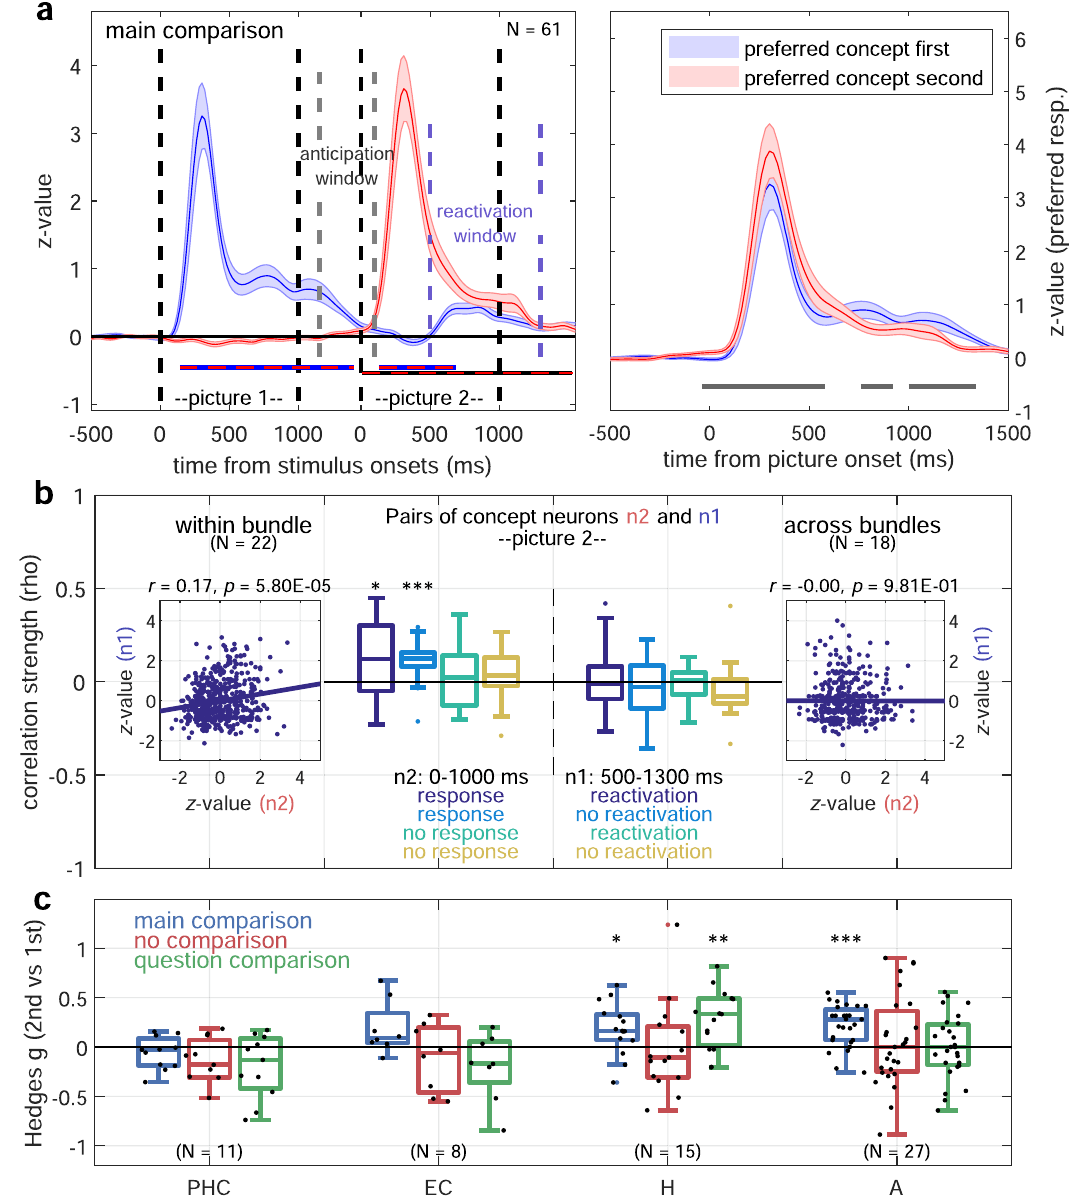
Fig. 5 Relational responses could arise from local interactions of concept neurons. a Left: Averaged normalized fi ring rates of concept neurons (mean ± SEM as shaded areas) when either the fi rst (blue) or second (red) picture was the preferred stimulus. Time periods of signi fi cant differences are indicated by solid lines in respective colors ( p < 0.01; two-sided cluster permutation test, black: zero). When the preferred concept was shown fi rst, neural activity increased before the onset of the second picture (anticipation window, gray dashed lines). Second responses (red) were stronger, and their late phase coincided with reactivations of units responsive to the fi rst picture (reactivation window, blue dashed lines). Right: Direct comparison of positional differences (two-sided cluster permutation test, periods of signi fi cant difference marked in dark gray). b Pairwise activity of concept neurons n2 and n1 with non-identical preferred stimuli during the main experiment in either the response (n2: 0 – 1000 ms) or the reactivation window (n1: 500 – 1300 ms) of picture 2. Pairs from the same hemisphere but different micro-wires were obtained from within ( N = 22, left) or across ( N = 18, right) wire bundles. Boxplots (Q1, median, Q3; whisker: points within ±1.5 IQR) of pairwise Spearman correlation effect sizes (rho) for different trials distinguished by color. Dark blue: both pictures preferred (n1: 1st picture, n2: 2nd picture). Light blue: only second picture preferred by neuron n2 (response). Turquoise: only fi rst picture preferred by neuron n1 (reactivation). Yellow: none of the pictures preferred. Pairwise correlation effect sizes signi fi cantly exceeded zero within bundles whenever the second picture was preferred by neuron n2: p (dark blue) = 2.21 × 10 − 2 , p (light blue) = 7.79 × 10 − 4 (two-sided Wilcoxon signed-rank tests). Inlets contain scatter plots and regression lines of normalized pairwise activity of trials when both pictures were preferred (dark blue). P values and effect size of regressions are shown on top c . Boxplots (Q1, median, Q3; whisker: points within ±1.5 IQR) of Hedges ’ g of positional differences of response activity to the preferred stimulus for all brain regions and experimental conditions (two-sided Wilcoxon signed-rank test against zero). During the main condition (blue), concept neurons of all brain regions, except PHC, responded more strongly to their preferred stimulus in the second position: p (EC) = 7.81 × 10 − 2 , p (H) = 2.15 × 10 − 2 , p (A) = 1.46 × 10 − 4 . In the no-comparison condition (red) no differences were present, and in the question- comparison condition (green) only the hippocampus exhibited higher fi ring during second picture presentations: p (H) = 6.71 × 10 − 3 . *** p < 0.001; ** p < 0.01; * p < 0.05 ( b , c , uncorrected). Source data are provided as a Source Data fi